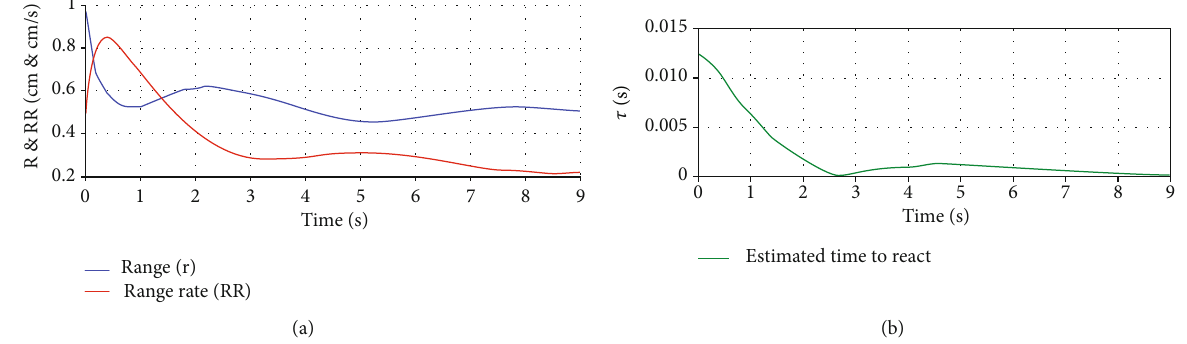
Figure 12: Root mean square errors from the estimation process for trajectories depicted in Figure 11. (a) Range and range rate. (b) Time to react. Table 1: Comparison of range-based assistive device with the device presented in the paper.